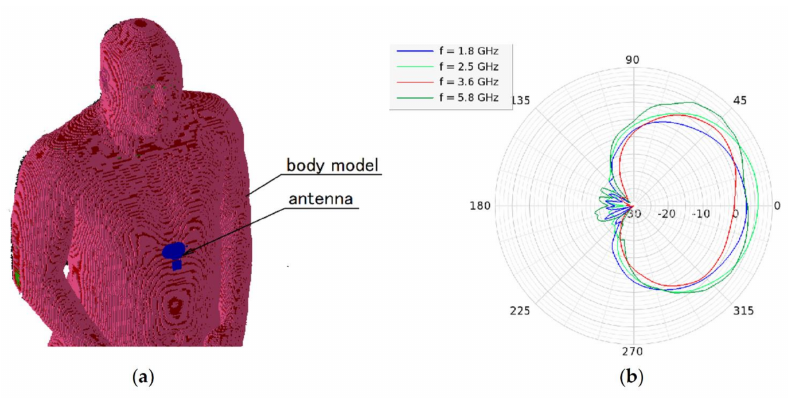
Figure 14. Three circle optimized antenna radiation pattern: ( a )—antenna position on heterogenous model. ( b )—radiation pattern in horizontal